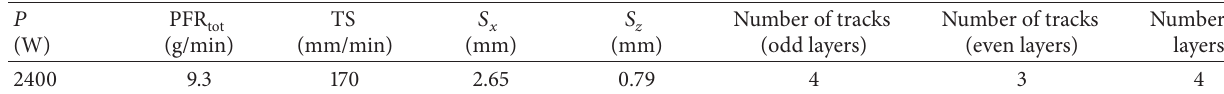
Table 5: Process and geometrical parameters.